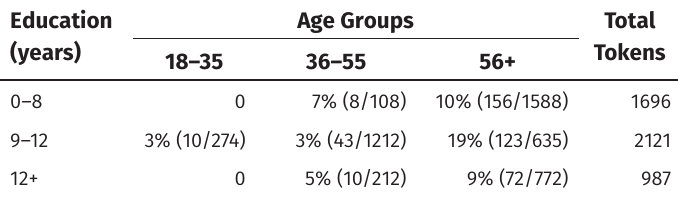
Table 4: Cross-tabulation of aspiration across age and level of